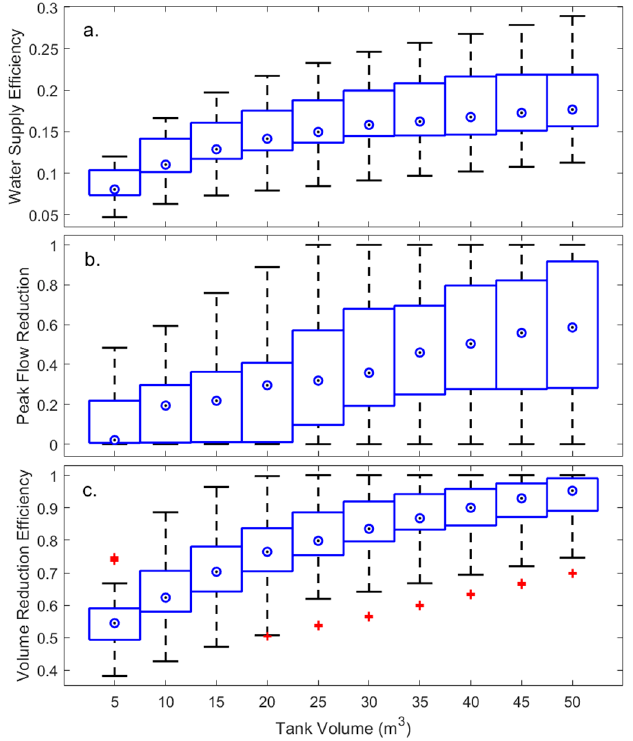
Figure 4. WSE PFR and VRE as a function of rainwater tank volume for the modeled building. Median values are marked as circles, boxes represent 25th and 75th percentiles, and whiskers 10th and 90th percentiles. Outliers are marked as red crosses. ( a ) WSE, ( b ) PFR, ( c ) VRE.